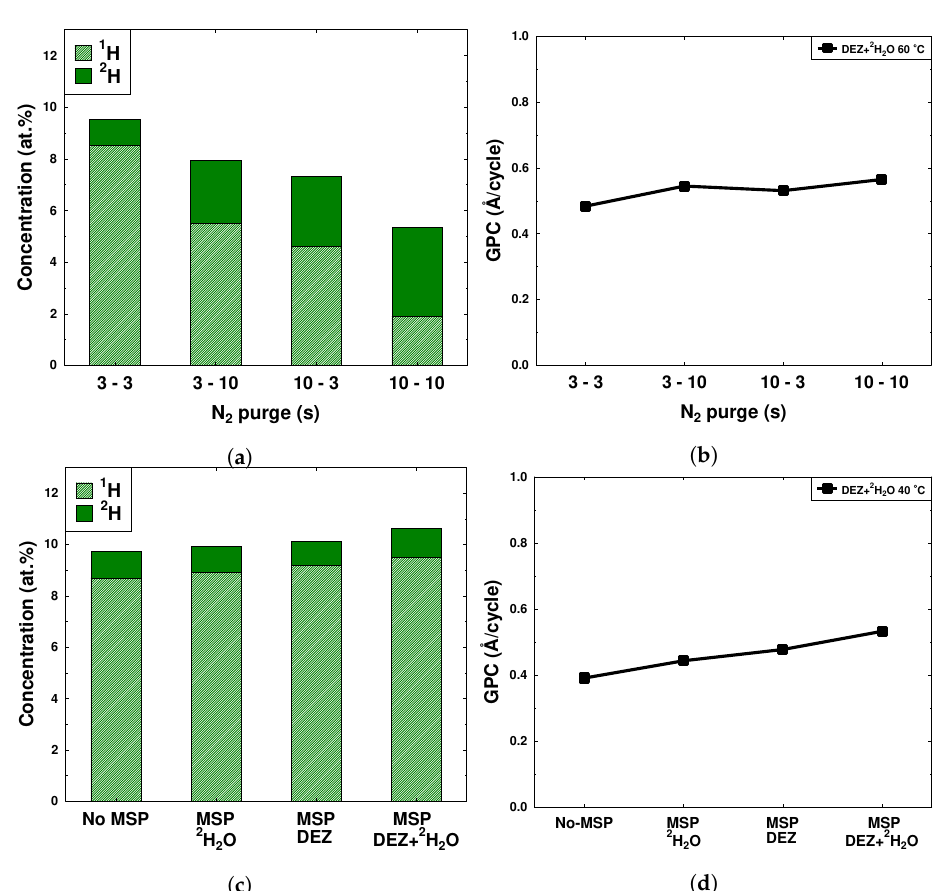
Figure 7. ( a ) Hydrogen and deuterium concentration with different N 2 purge schemes deposited at 60 ◦ C. ( b ) Growth per cycle with different N 2 purging schemes deposited at 60 ◦ C. ( c ) Hydrogen and deuterium concentration when multiple short pulses (see text) were used at 40 ◦ C. ( d ) Growth per cycle using multiple short pulsing at 40 ◦